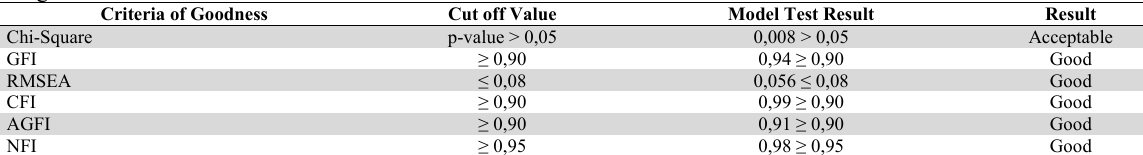
The goodness of Fit Statistics Result Criteria of